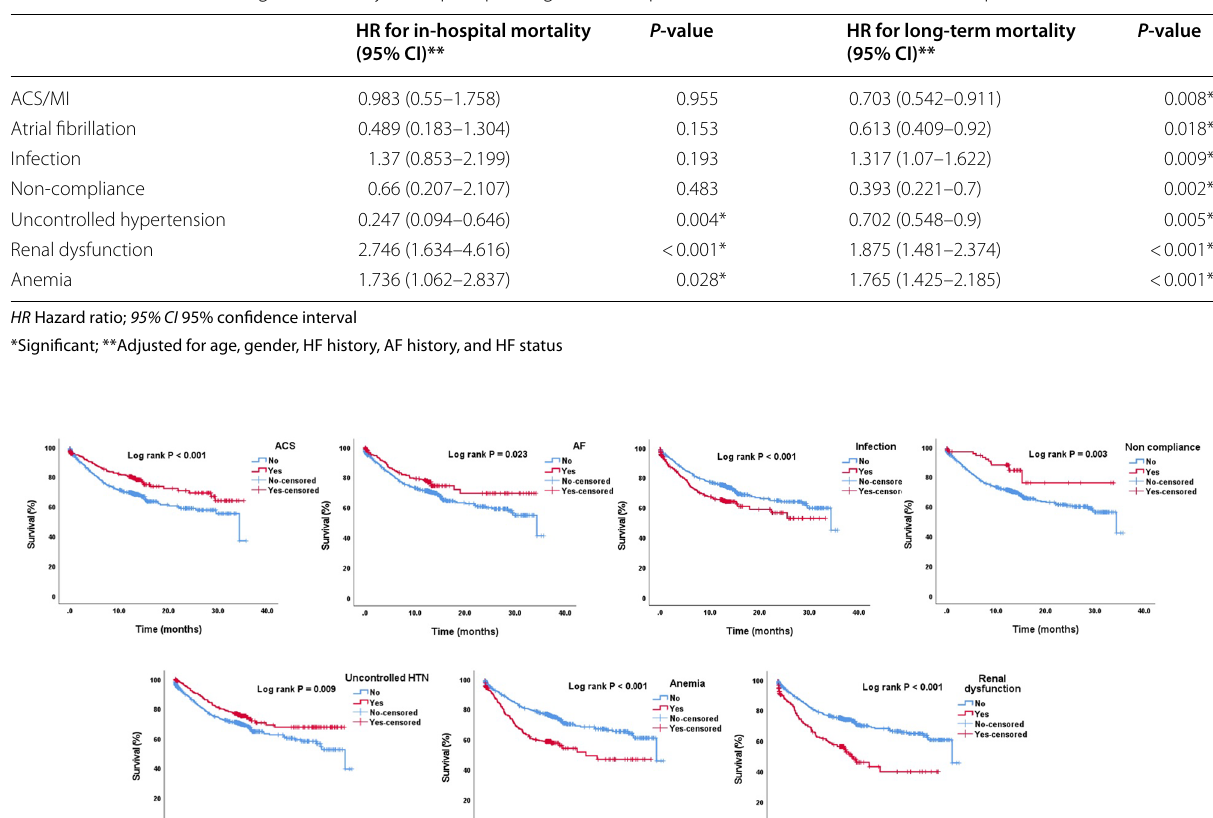
Table 4 Multivariate cox regression analysis for precipitating factors to predict overall survival of the studied patients